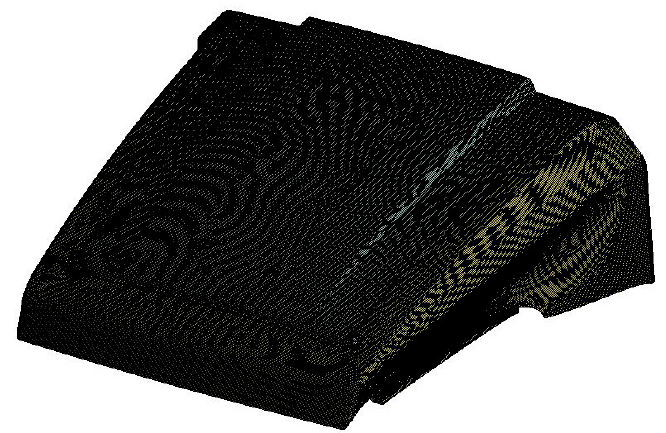
Figure 10. Finite element model of faring.